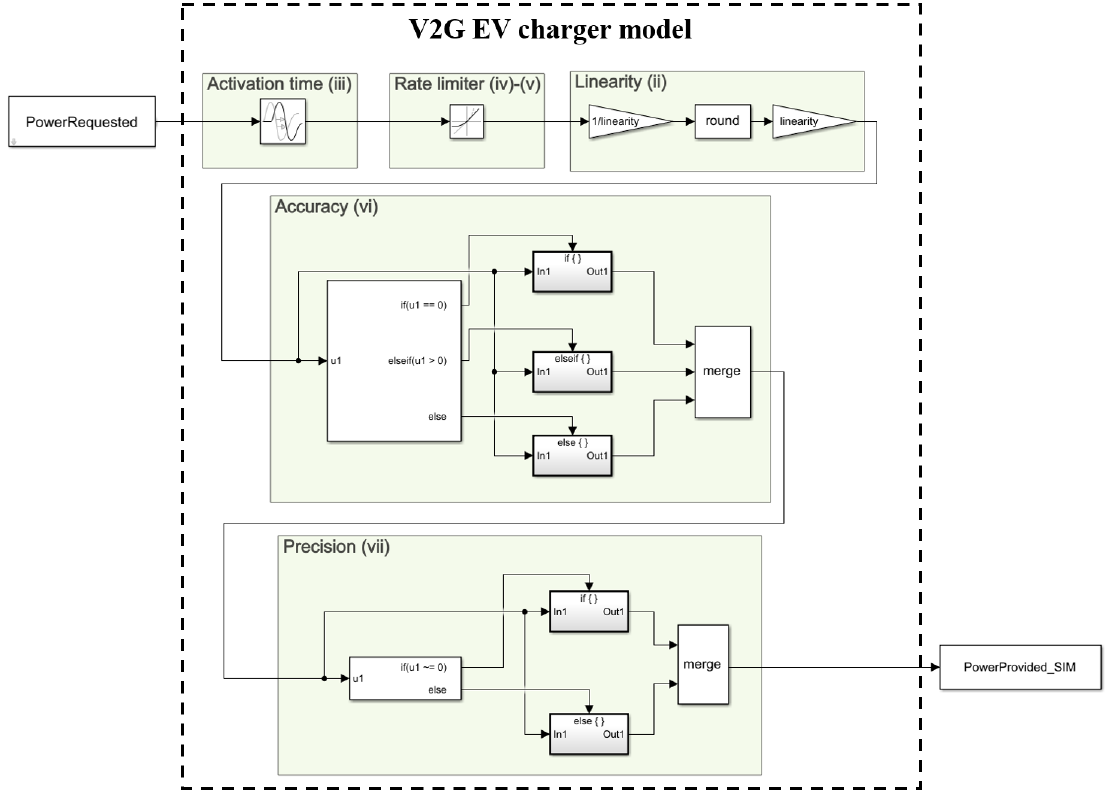
Figure 11. EV charger model.